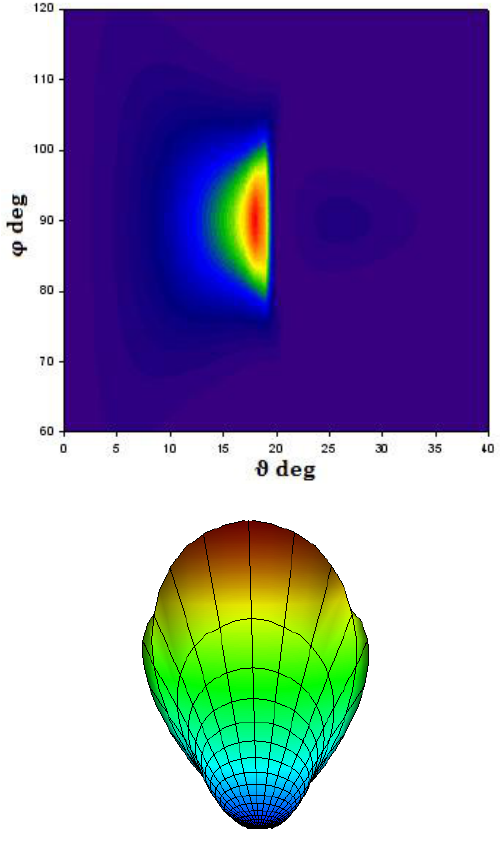
Figure 6b: The pattern of transmitted field f =37,2 GHz